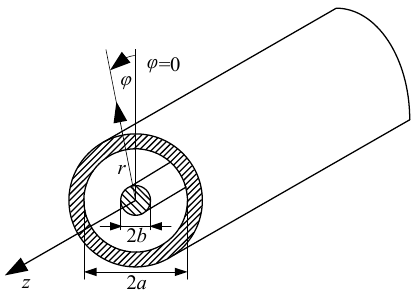
Figure 4. Coaxial line under the cylindrical coordinate system.